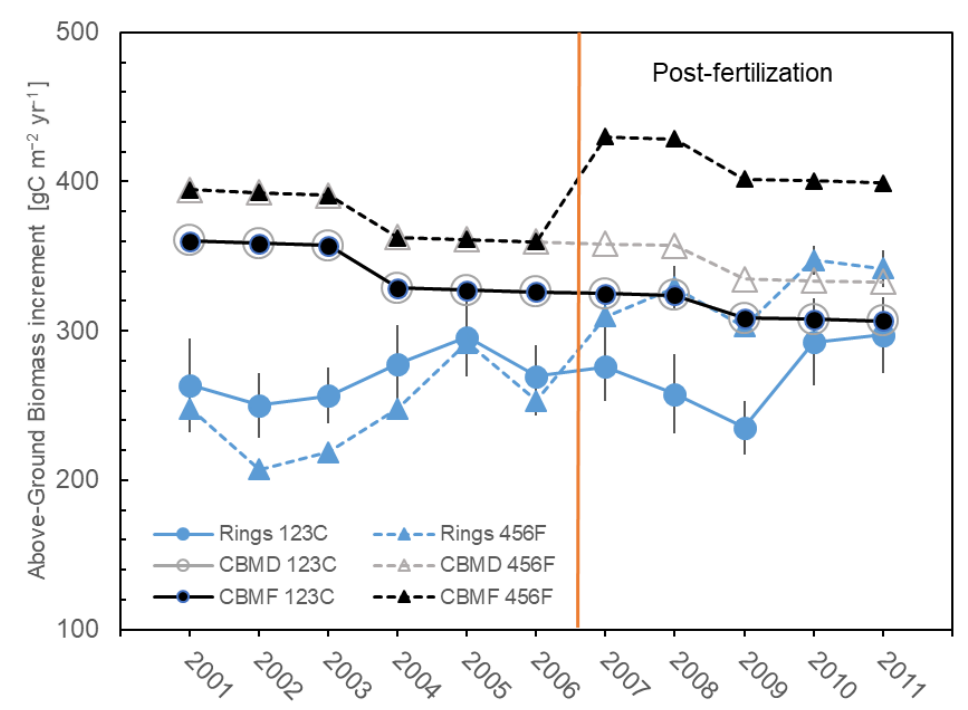
Figure 3. Annual above-ground biomass carbon increments from the CBM-CFS3 model for control (123C solid line, circles) and fertilized (456F, dashed line triangle) plots using yield curves derived from plot tree-ring data (Rings), default stand type yield curves without a fertilizer effect (CBMD gray lines, open symbols), or default yield curves with a fertilizer effect (CBMF black line, closed symbols). Rings data show plot mean with one standard error.